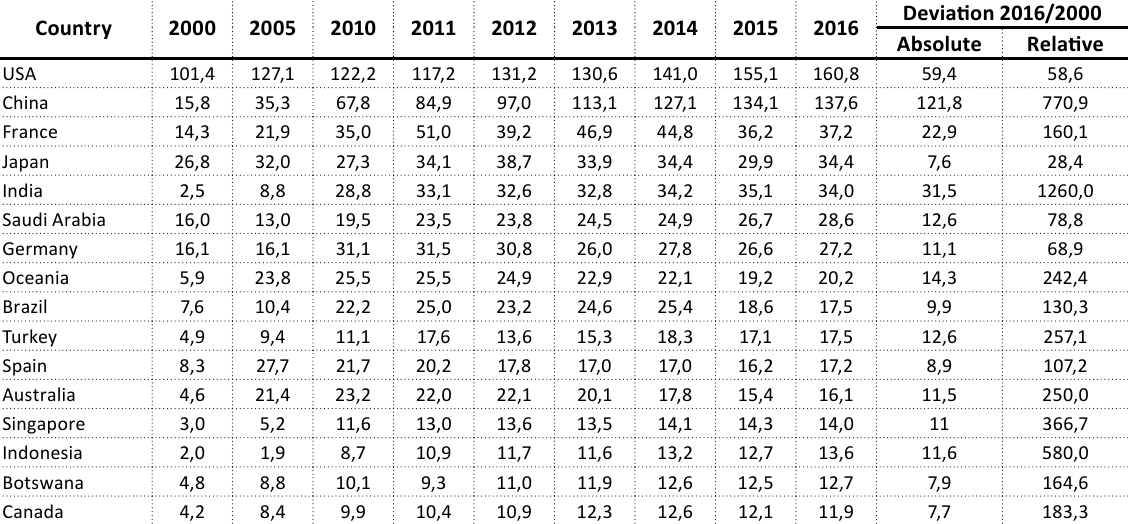
Table 2. Leading countries in terms of investment in tourism for the period 2000–2016, USD billion